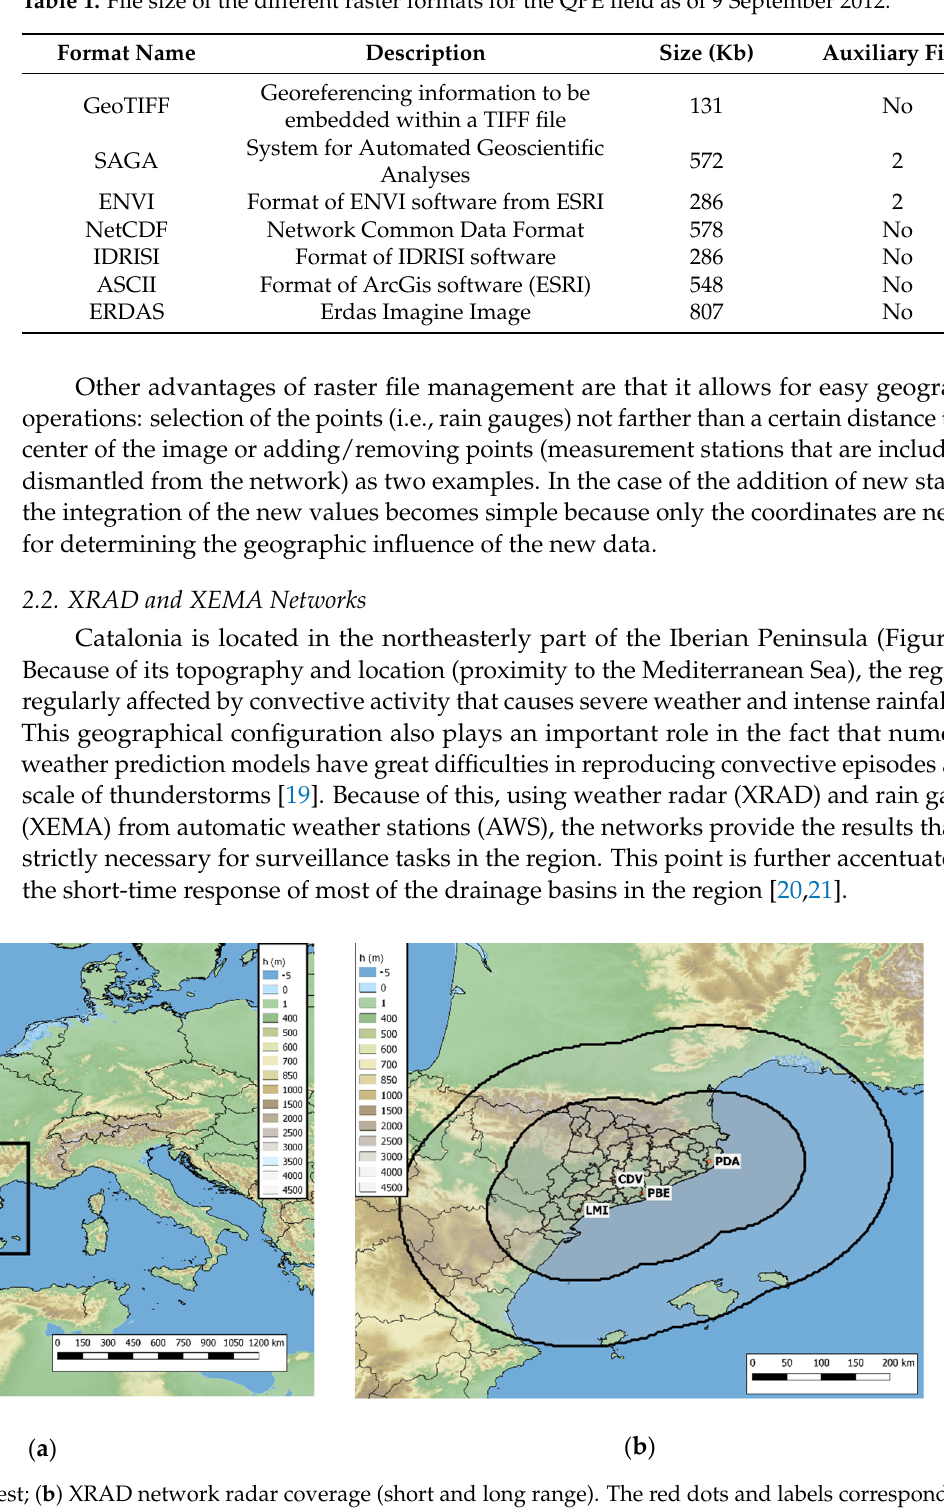
Figure 1. ( a ) Area of interest; ( b ) XRAD network radar coverage (short and long range). The red dots and labels correspond to the four radars: CDV (Creu del Vent), LMI (La Miranda), PBE (Puig Bernat), and PDA (Puig